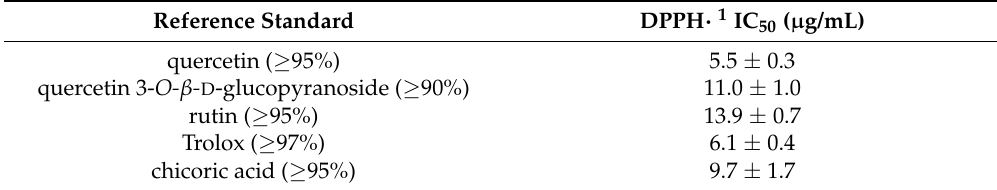
Table 2. IC 50 values of reference standards.